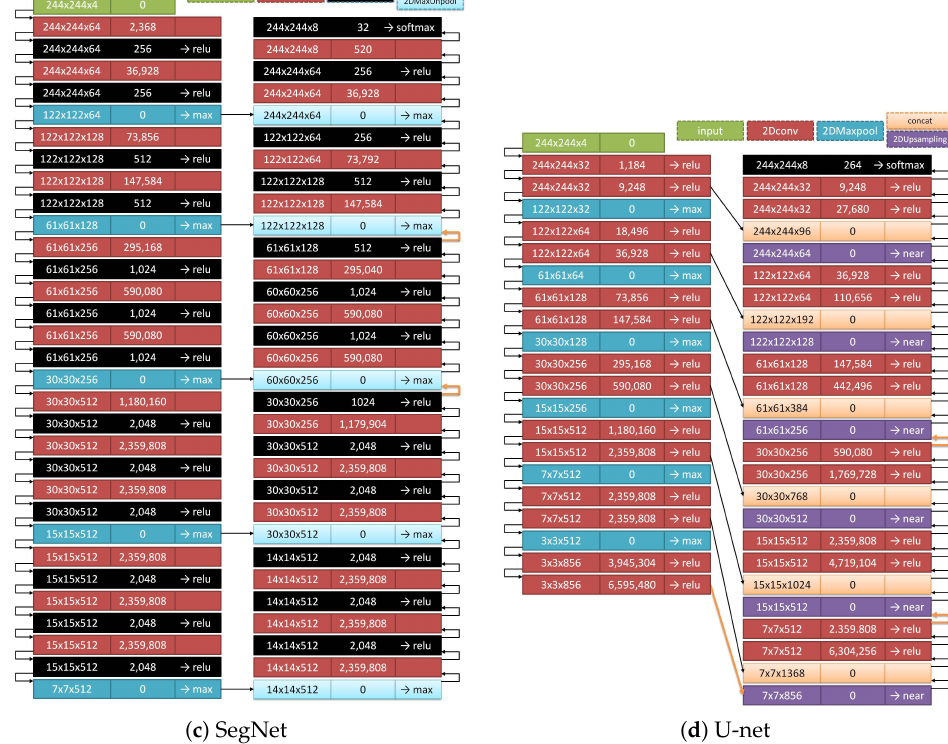
Figure 3. The four CNN variants tested in this study. Each network layer is described by the shape of the array it handles, the number of parameters to be estimated, and the mathematical operation that has produced the array. In total, eight building blocks (layers) are employed to compose the networks: input , 2Dconv , batchNorm , dense , 2DMaxpool , 2DMaxUnpool , 2DUpsampling , and concat . Each layer is connected with the next one via a black arrow showing the direction of the coupling. A thicker orange arrow signifies the connection of two layers where the output array of the first layer has been upsampled appropriately to match the spatial resolution of the array that the second layer accepts as